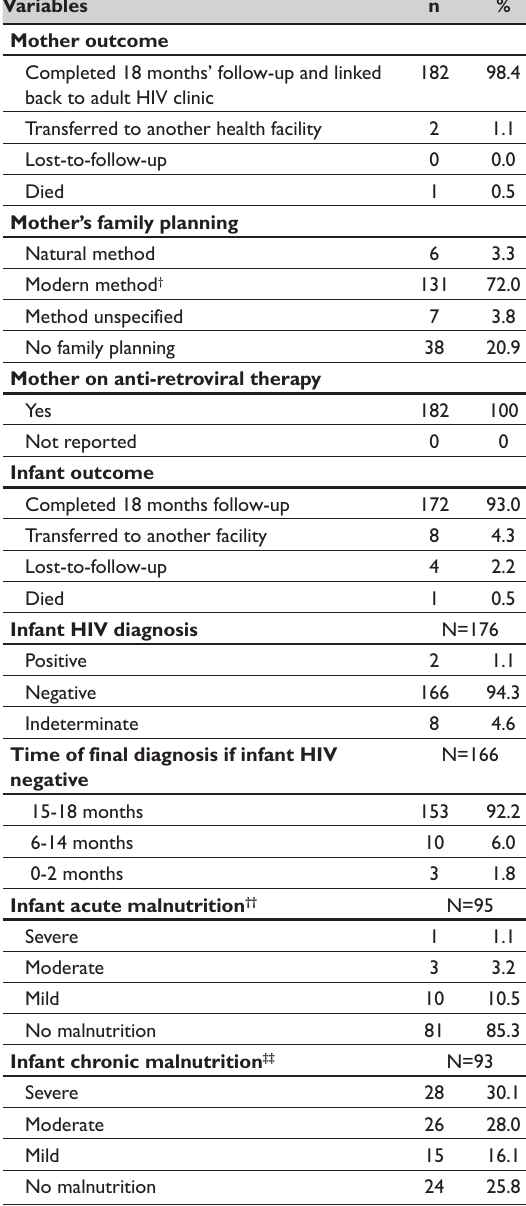
Table 3: Mother-infant outcomes in the Combined